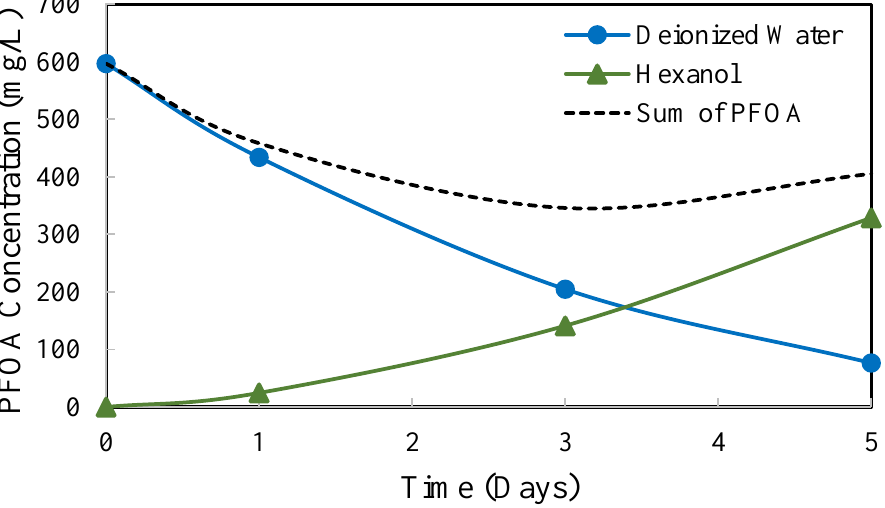
Figure 12. Perstraction of PFOA from DI water into 1-hexanol through a PDMS membrane.